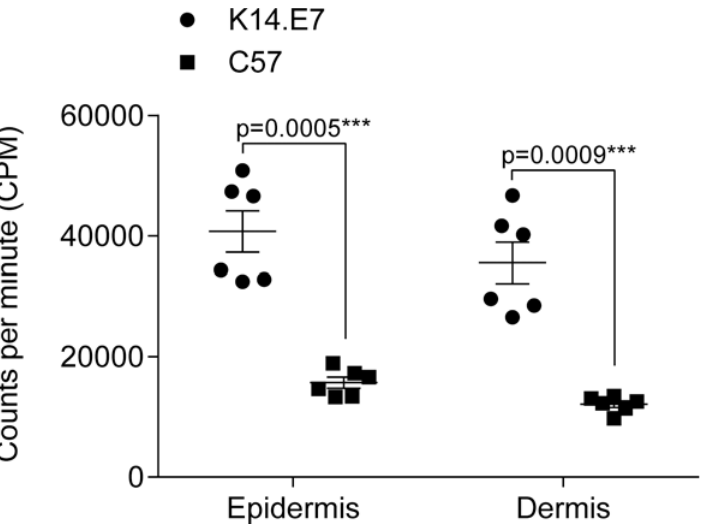
Fig 5. Isolated skin-derived DCs of K14.E7 mice present antigen in vitro, and induce CD8 + T cell proliferation. DCs (CD45 + CD11c + MHCII + ) were sorted from ear epidermis and dermis of 10 pooled C57BL/ 6 and 8 pooled K14.E7 mice and co-cultured together with sorted splenic OT-I CD8 + T cells and SIINFEKL at a 1:10 ratio with 5x10 4 total cells per well. After 72 hours cells were incubated overnight with 3 H-thymidine and uptake was determined. Shown are triplicates of two pooled independent